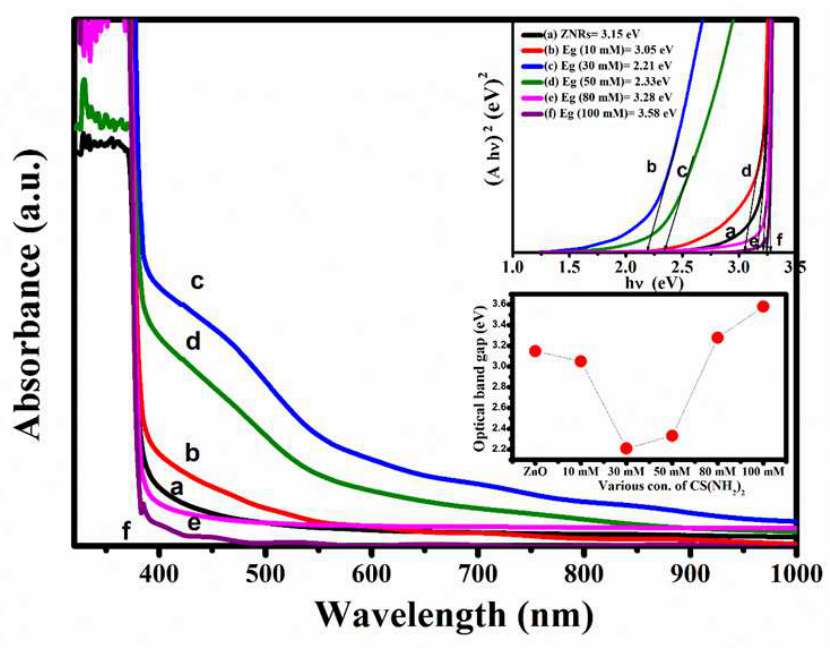
Figure 7. UV-vis spectra and Tauc plot for the direct allowed transitions (presented in insets of Figure 7: UV–Vis spectra and energy band gap graphs (presented in insets of the figure) 296 the figure) of ZnO NRs/ITO ( a ), and Ag 2 S/ZnO NRs/ITO prepared at various concentrations of of: ZnO NRs/ITO (a), and Ag 2 S/ZnO NRs/ITO prepared at various concentrations of 297 CS(NH 2 ) 2 : ( b ) 0.01 M; ( c ) 0.03 M; ( d ) 0.05 M; ( e ) 0.08 M; and ( f ) 0.1 CS(NH 2 ) 2 : (b) 0. 01 M; (c) 0. 03 M; (d) 0. 05 M; (e) 0.08 M; and (f) 0.1 M. 298